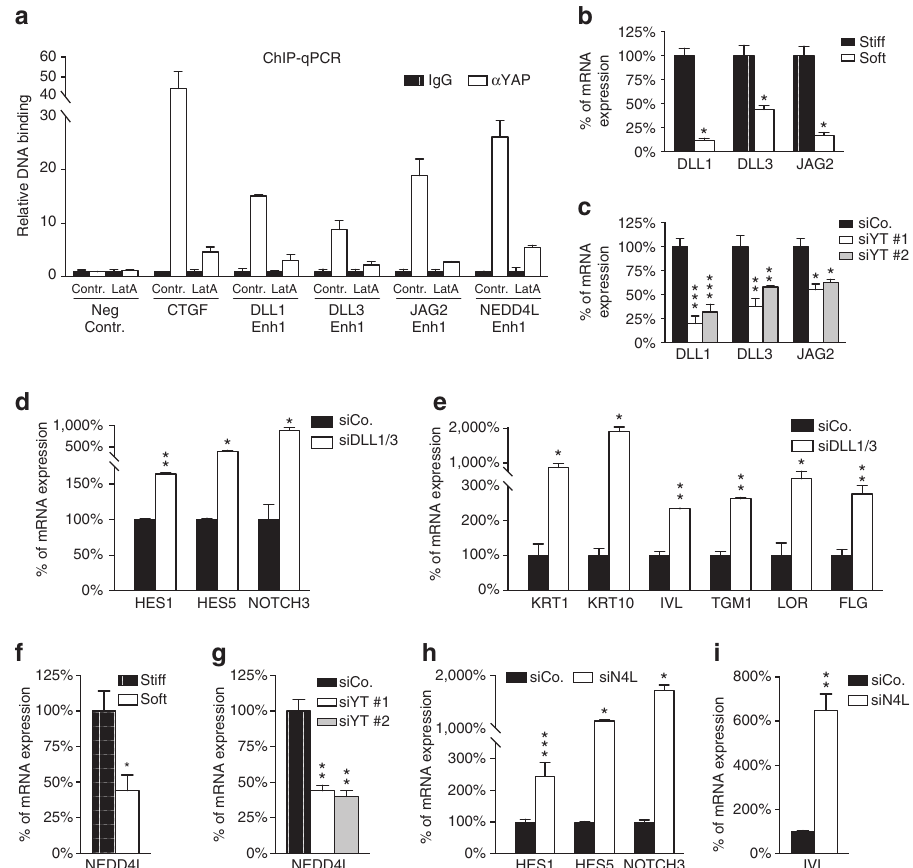
Figure 7 | YAP/TAZ transcriptionally control Notch regulators. ( a ) Validation by ChIP-qPCR of YAP/TAZ-binding sites identified through combination of YAP/TAZ ChIP-seq and Hi-C (see Supplementary Data 1). ChIP-qPCR of the CTGF promoter is a positive control; HBB is a negative control locus (Neg Contr.). Data from two biological replicates (mean þ s.d.) from one representative experiment out of three are shown. ( b , c ) Mechano-YAP/TAZ- dependent regulation of Notch ligands. nHEK cells were either plated on stiff or soft conditions ( b ) or transfected with control siRNA (siCo.) or with independent siYAP/TAZ ( c ). Cells were analysed by qRT–PCR for DLL1 , DLL3 and JAG2 . Values were normalized and statistically compared to stiff ( b ) or to siCo. treated ( c ). Bars represent mean þ s.d. ( n ¼ 3 independent experiments. * P o 0.0001 in b ; *** P o 0.0001, ** P o 0.01, * P o 0.02 in c ; two-way analysis of variance (ANOVA)). ( d , e ) nHEK cells transfected with control siRNA (siCo.) or with a mix of siRNAs targeting both DLL1 and DLL3 mRNAs (siDLL1/3) were replated at single-cell density to minimize the effect of trans -signalling of Notch ligands. qRT–PCR for the expression of the Notch target genes HES1 , HES5 and NOTCH3 ( d ) and for a panel of differentiation markers ( KRT1 , KRT10 , IVL , TGM1 , LOR , FLG ) ( e ). Bars represent mean þ s.d. (* P o